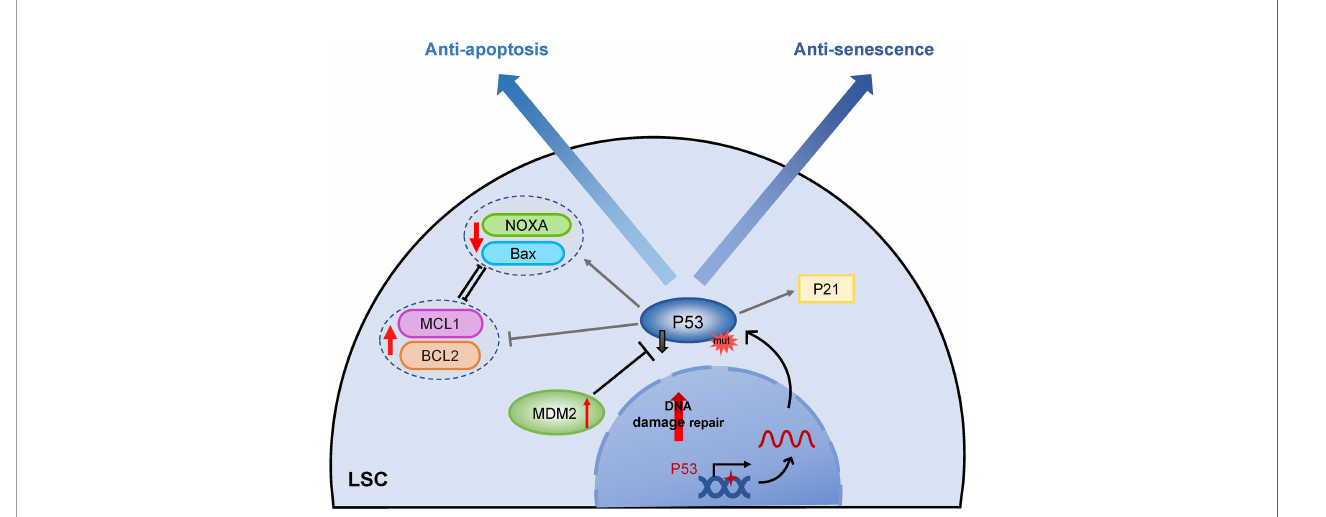
FIGURE 4 | The role of TP53 in apoptosis and senescence. Mutations or inactivation of p53 plays an important role in both apoptosis and senescence resistance of LSCs. While LSCs with mutant P53 are unable to activate downstream P21 to enter the senescent process, they do not target apoptosis pathway proteins including induction of pro-apoptotic proteins like Bax, and apoptosis initiator groups like NOXA and repressing anti-apoptotic members BCL2 and MCL1, eventually fail to initiate apoptosis. MDM2, minute 2 homolog; BCL2, B-cell lymphoma 2; MCL1, myeloid cell leukemia sequence 1; Bax, Bcl-2-associated X protein; NOXA, proapoptotic BH3-only